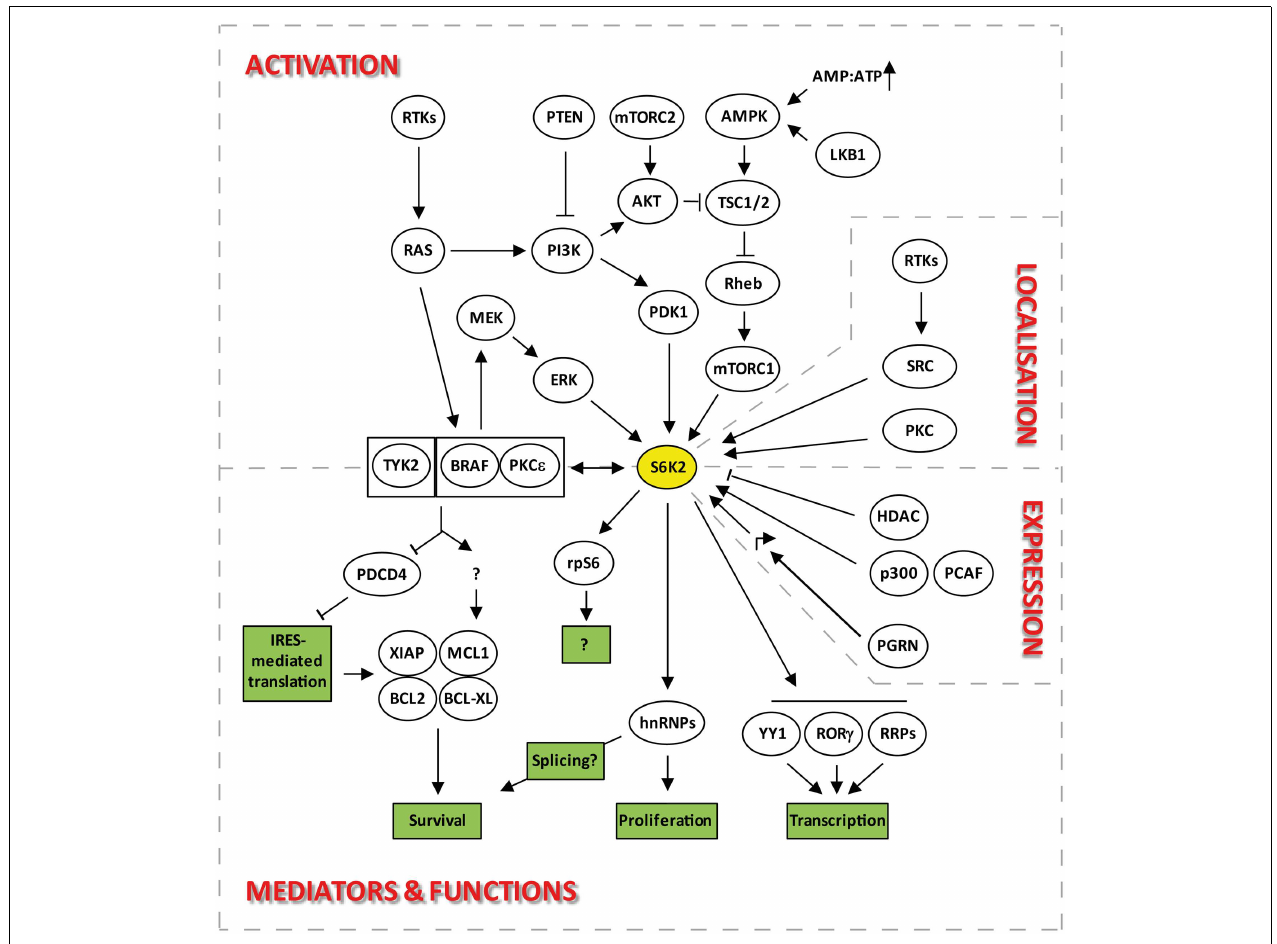
FIGURE 2 | Signaling pathways upstream and downstream of S6K2 that regulate its activation, localization, expression, and functions .